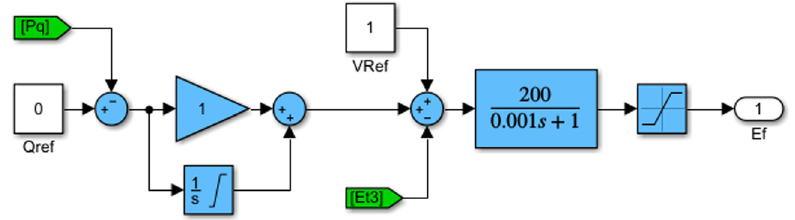
Figure 8: Excitation control diagram of the synchronous generator with ST1A and VAR Type 2.